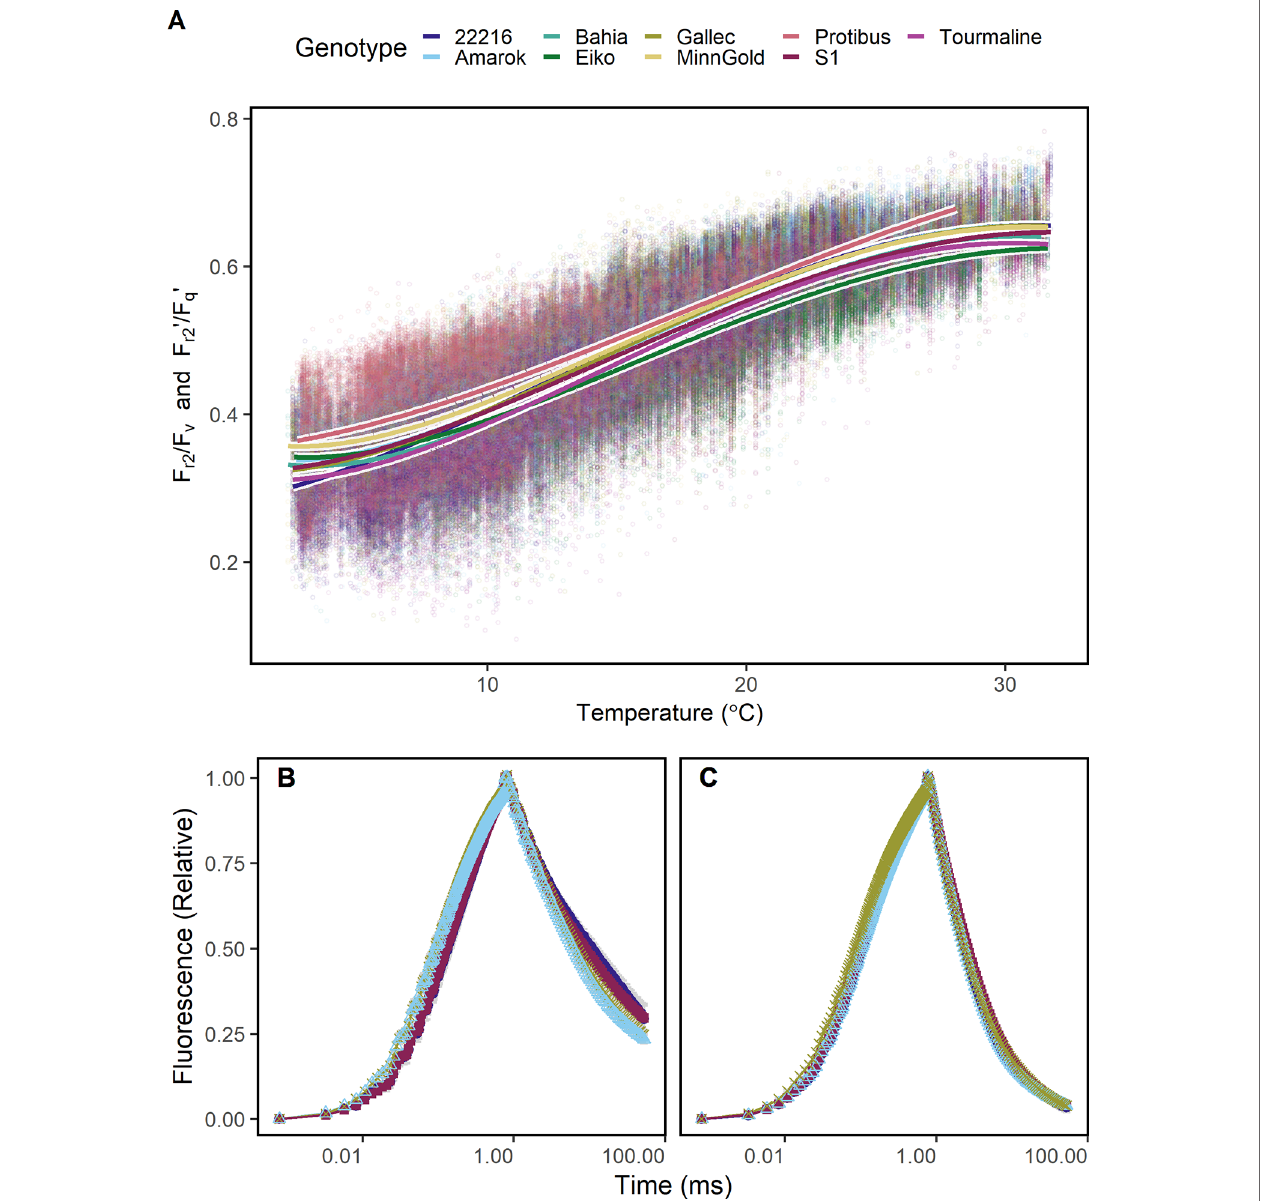
FIGURE 5 | Chlorophyll fluorescence transients were measured in soybean canopies of different genotypes over two seasons under fluctuating conditions. (A) Efficiency of electron transport 5 ms after reduction of primary quinone (Q A ) (F r2 /F v in the dark, F r2 '/F q ' in the light) of soybean genotypes differing in cold tolerance are shown. F r2 /F v and F r2 '/F q ' were fitted to a linear model depending on temperature (including a square root and a squared temperature term). (B) A contrasting subset of chlorophyll fluorescence transients of genotypes 22216, Amarok, Gallec, and S1 at 4°C and (C) 20°C is shown. F r2 /F v and F r2 '/F q ' calculated from these data are shown in Supplementary Figure 5 . For each temperature level, measurements were selected from October and November 2016 which had data recorded at the indicated temperature ( ± 0.5°C) between noon and dawn. Error bars show 95% confidence interval of the mean (n = 33 to 161 measurements). Genotype Amarok and Gallec are breed for cold tolerance. Light-induced fluorescence transient (LIFT) method was used with fast repetition rate flash from about 1 m distance scanning over the crop canopy. Temperature was recorded every minute by three stations distributed in the unheated glasshouse and linked to LIFT measurements done in the same